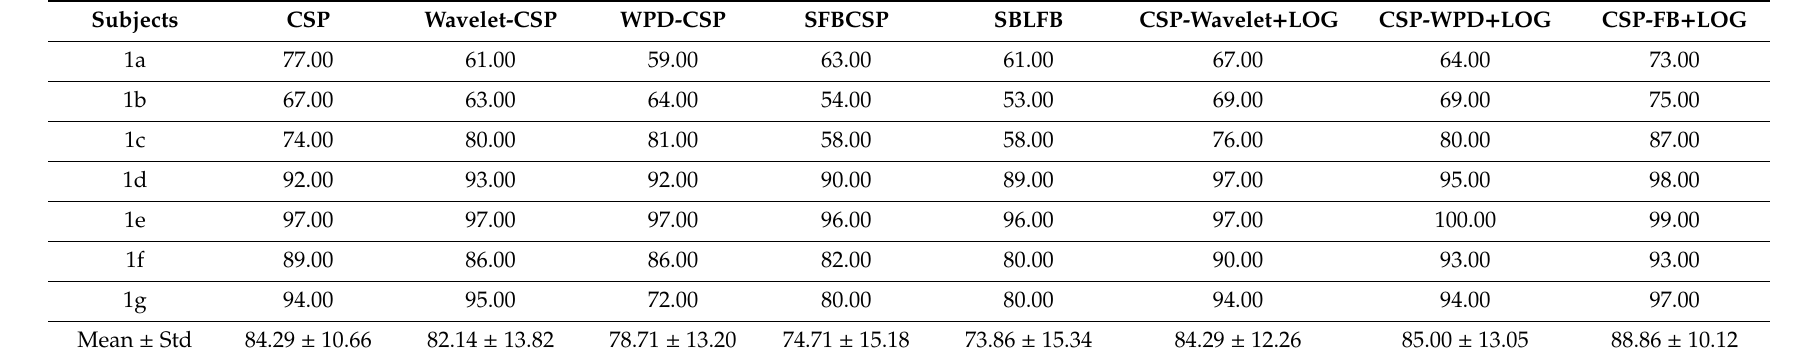
Table 2. Classification accuracy (Dataset 1).